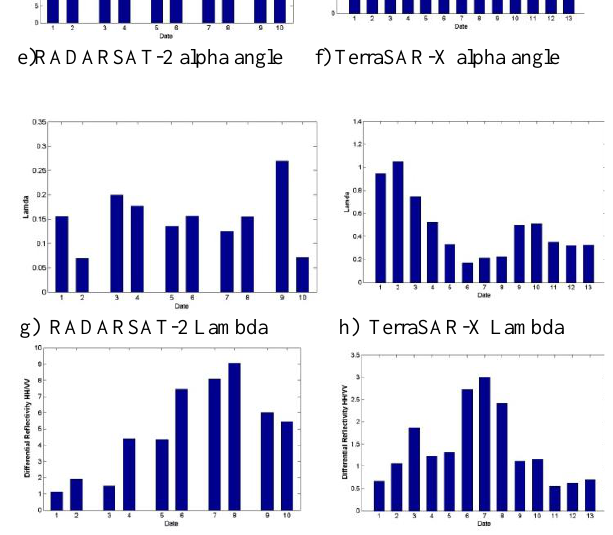
RADARSAT-2 and TerraSAR-X displayed in Figure 4, more RADARSAT-2 polarimetric features are displayed in Figure 5, which also demonstrate the changes with crop growth stages.